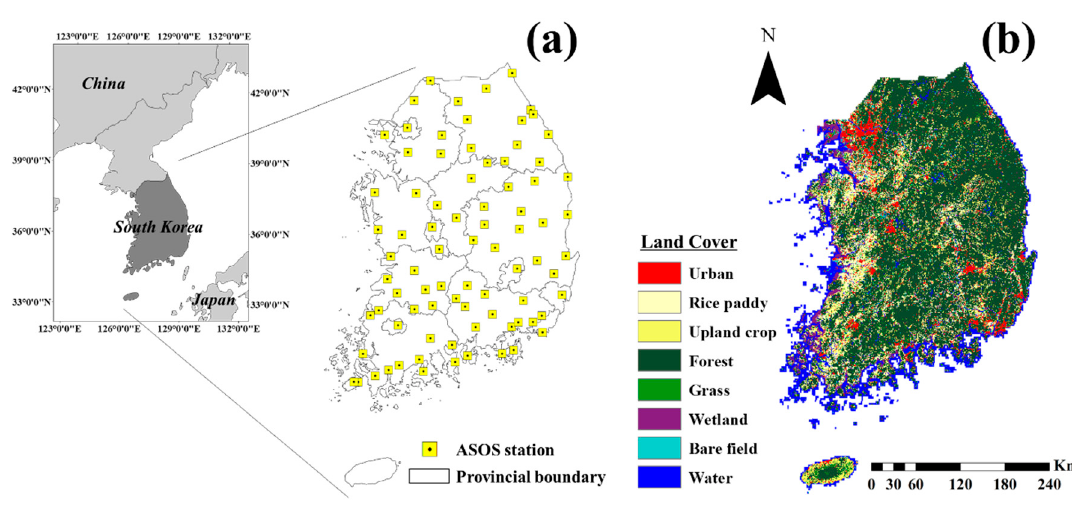
Figure 2. Relevant information on the study area. ( a ) Location of 79 Automated Synoptic Observing System (ASOS) weather stations and ( b ) Resampled land use map.